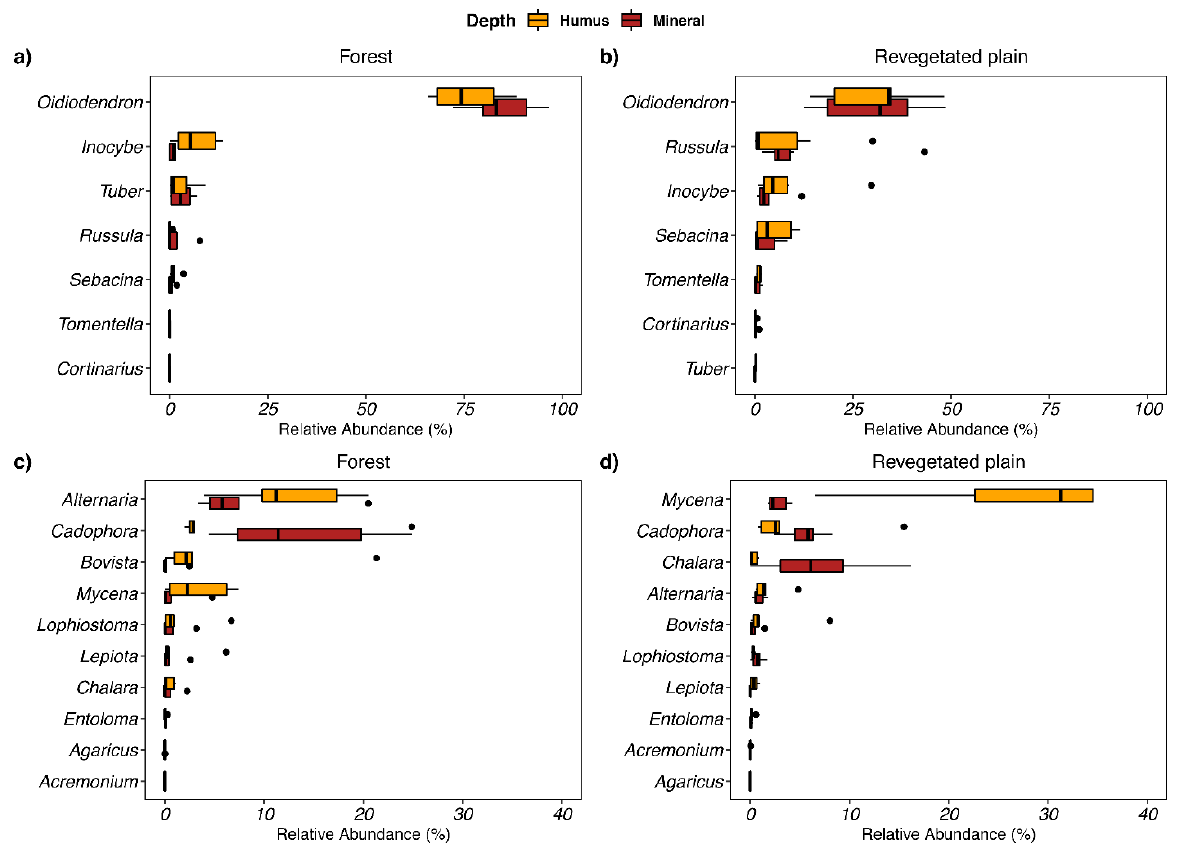
Figure 4. Boxplots of relative read abundance (%) of the most abundant a – b) mycorrhizal fungi and c – d) saprotrophic fungi in the holm oak forest and revegetated plain soil layers (humus-H and mineral